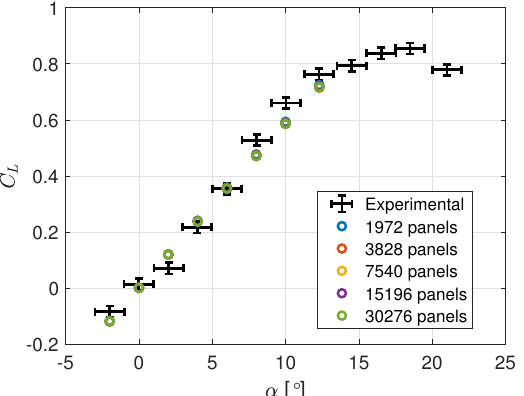
Figure 4. C L vs. α curve for different panel resolution (APAME); kite geometry can be found in Table 4 [20].